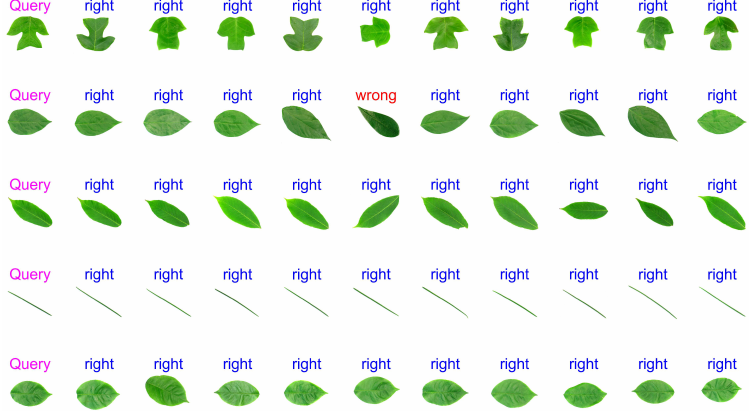
Figure 15. Top 10 retrieval images for five leaf images from Flavia dataset.